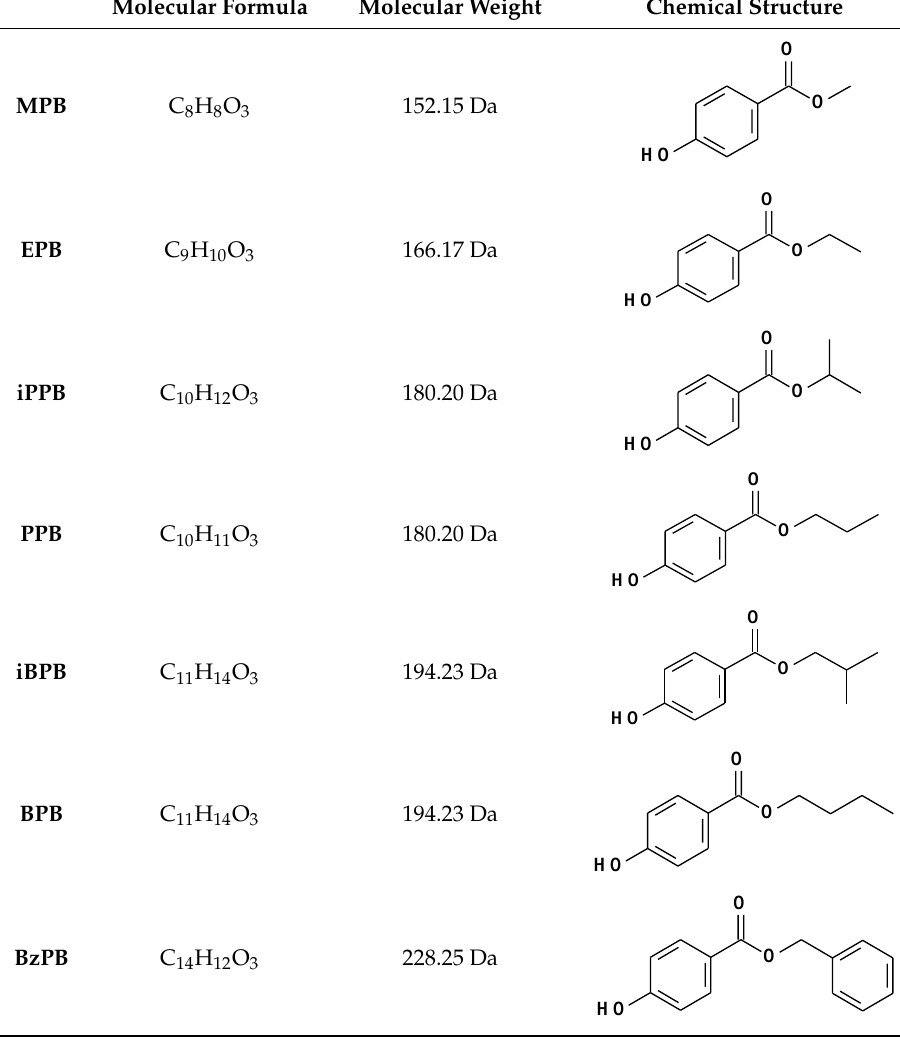
Table 1. General chemical – physical characteristics of parabens and their chemical structures. Molecular Formula Molecular Weight Chemical Structure